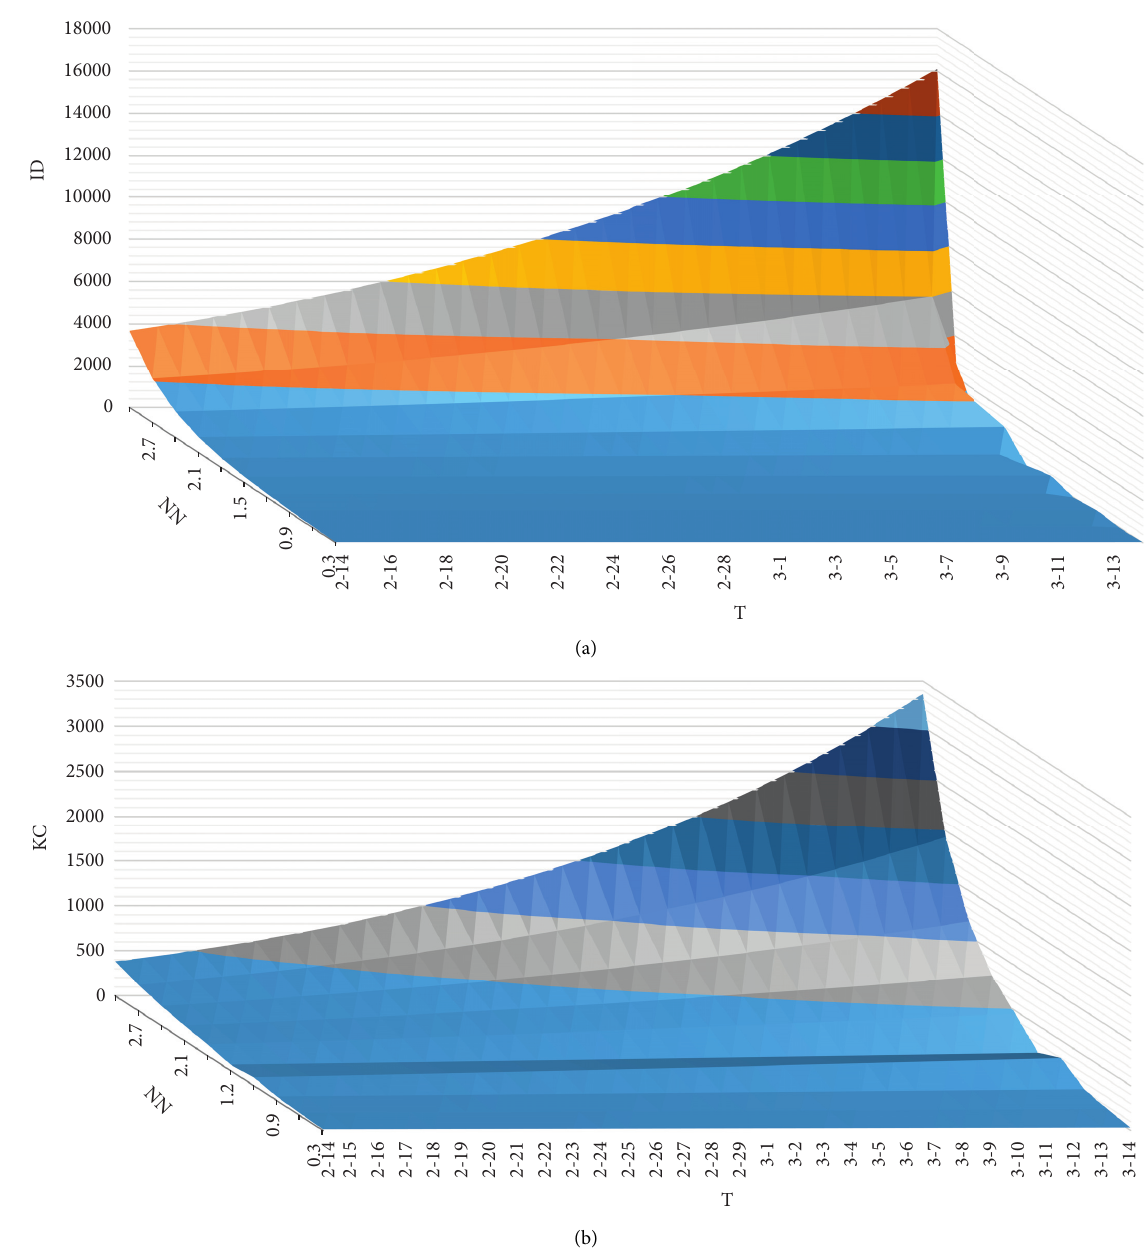
Figure 11: Trend of ID and KC under different